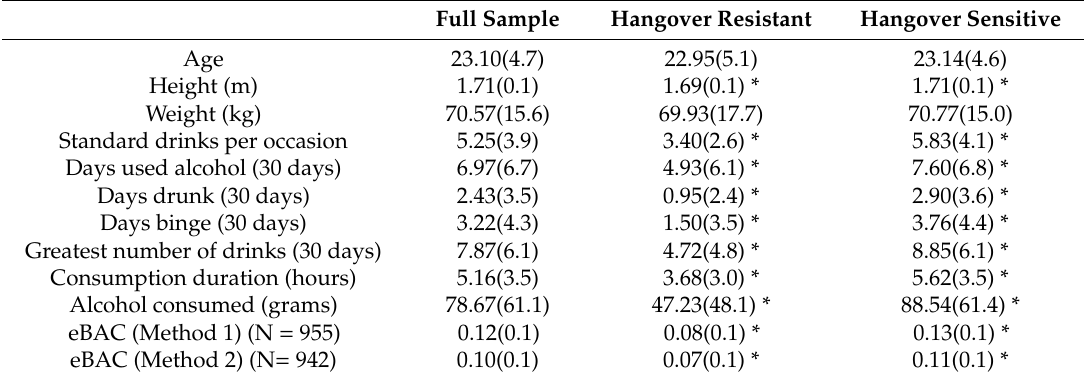
Table 1. Participant morphometrics, demographics, and drinking characteristics. Numbers are means with standard deviations in parentheses. * p < 0.05 between hangover resistant and hangover sensitive group of